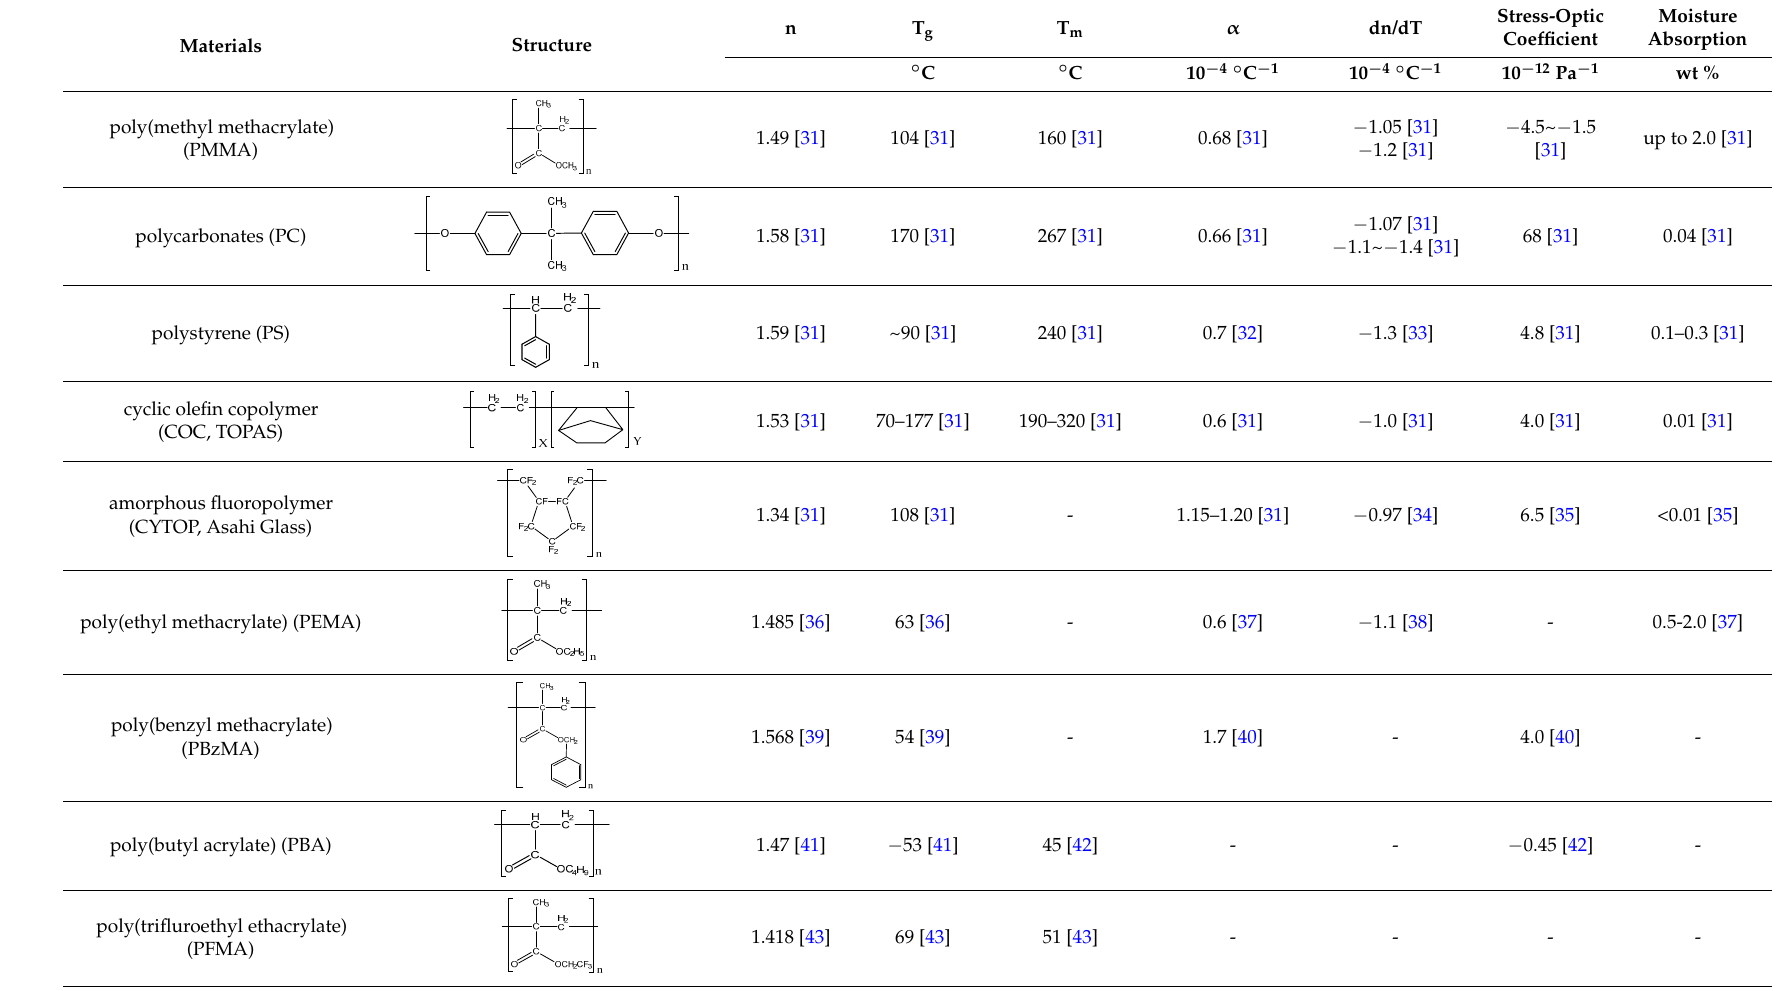
Table 1. The properties of host materials for POF gratings.